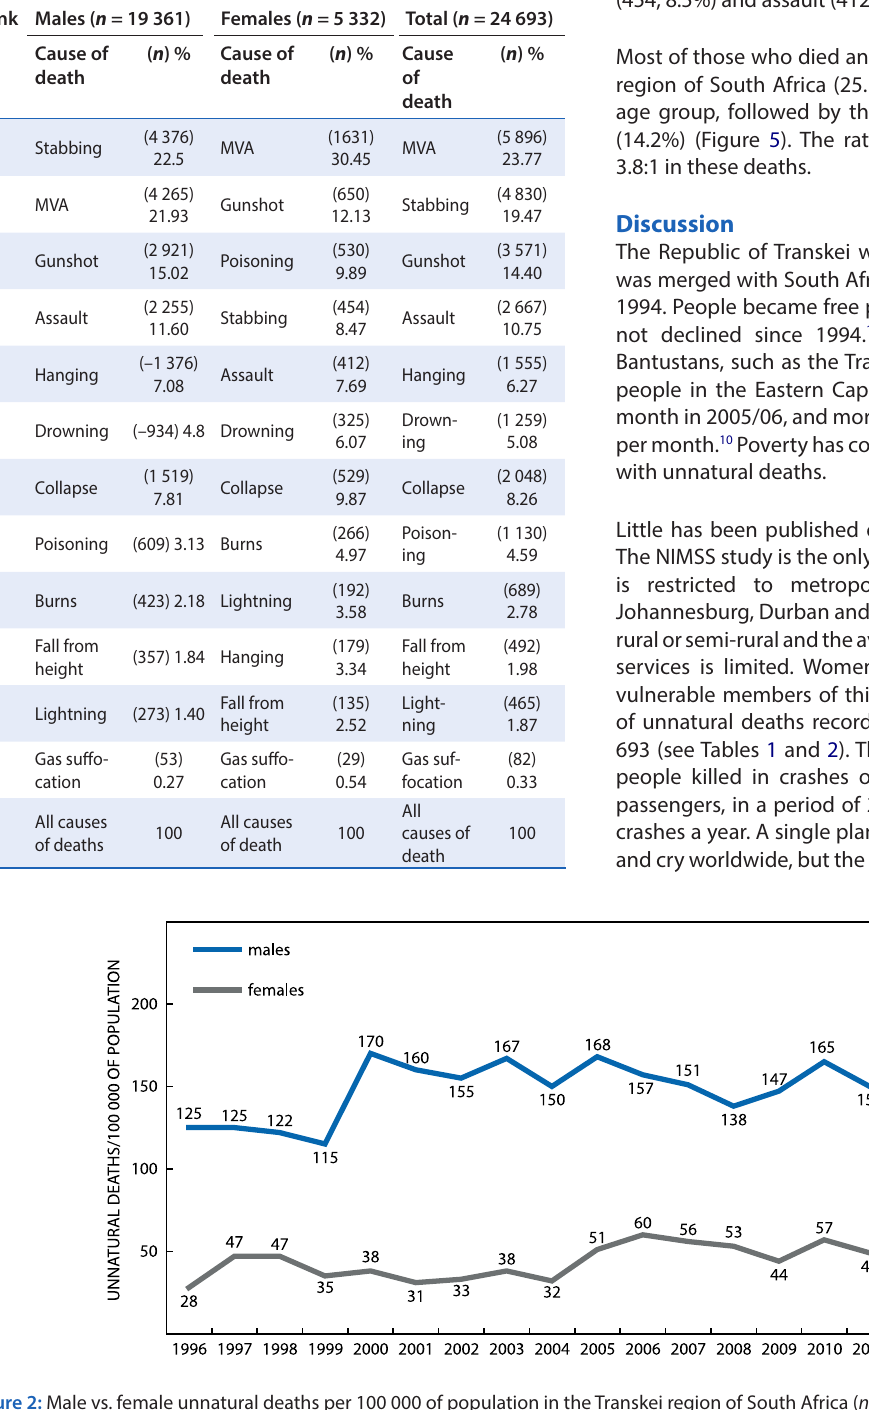
Figure 2: Male vs. female unnatural deaths per 100 000 of population in the Transkei region of South Africa ( n = 24 693).